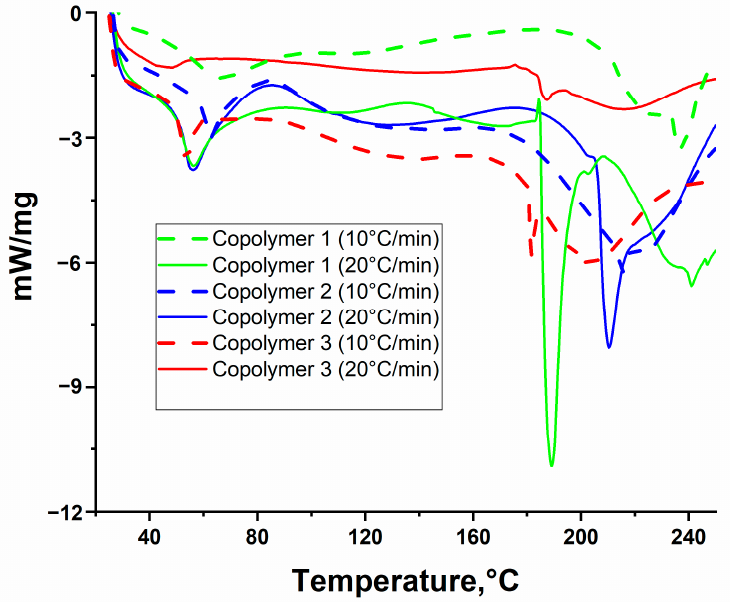
Figure 4. TGA ( a ) and DTG ( b ) curves (heating rate of 10 K ∙ min − 1 ) of copolymers with 1 wt.%